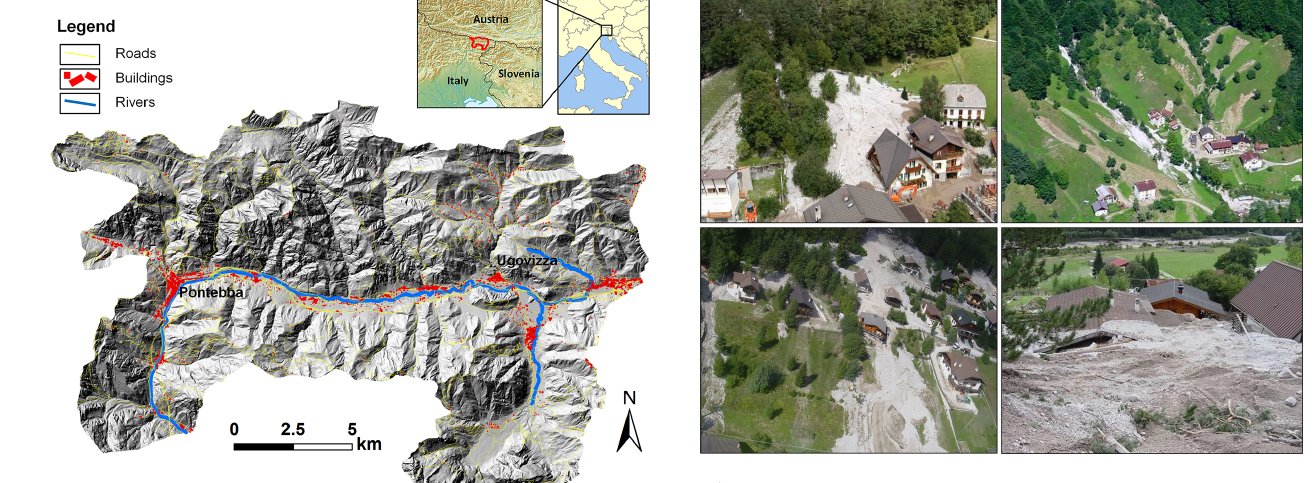
Figure 9. Debris flow events in Fella River basin in August 2003 ( © Civil Protection of Friuli-Venezia Giulia region,